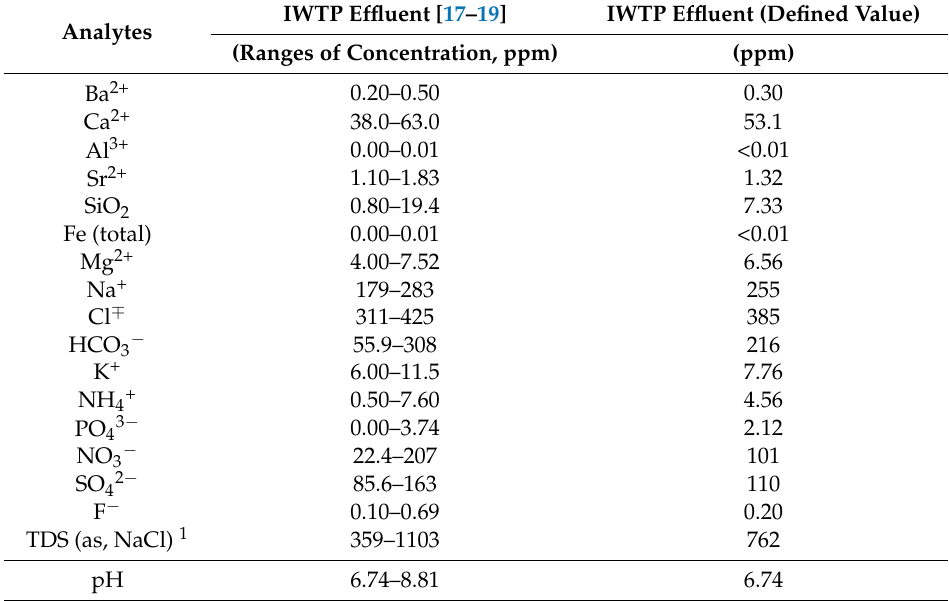
Table 1. Characteristic values of indicators in effluent. IWTP: industrial wastewater treatment